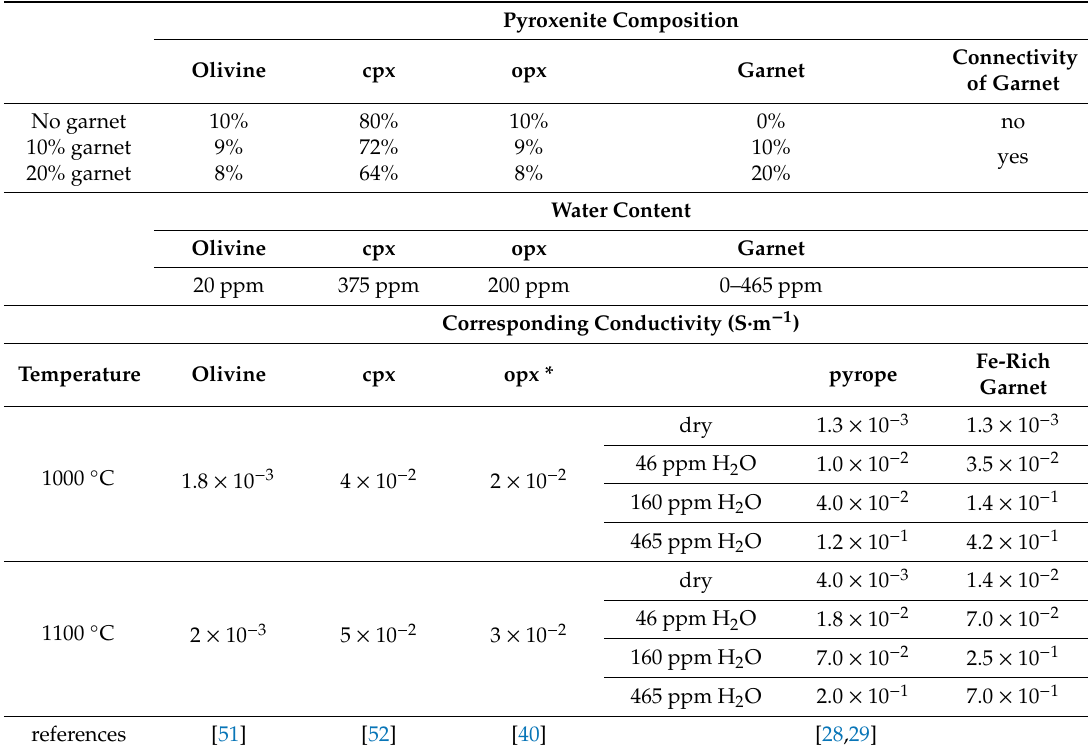
Table 2. Parameters used for electrical conductivity